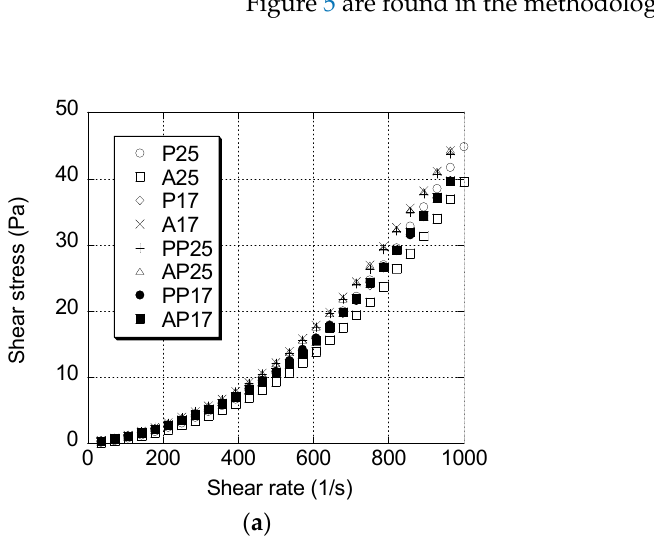
Figure 4. Water kefir SFP samples behavior ( a ) at 25°C and ( b ) at 35° .